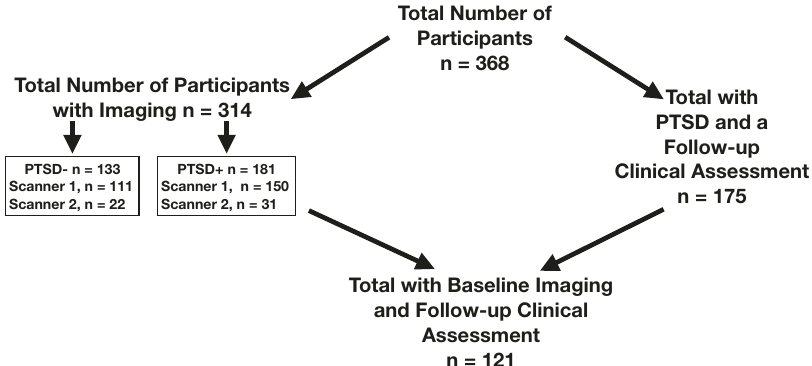
Fig. 1 Participants. The participants available at the start of the study were collected in TRACTS between 2010 and 2017. The current study includes the fi rst 368 participants with veri fi ed clinical data, cognitive data, who passed a performance validity test and had either neuroimaging or longitudinal clinical data. Of these 368 participants, 314 had veri fi ed resting-state fMRI and anatomical neuroimaging (181 meeting criteria for PTSD). 175 participants with PTSD had a follow-up clinical assessment, and 121 of these participants had both baseline neuroimaging and a follow-up clinical assessment. Scanner 1 was a 3 T Siemens TIM Trio scanner using a 12-channel head coil, Scanner 2 was a 3 T Siemens MAGNETOM PrismaFit scanner using a 20-channel head